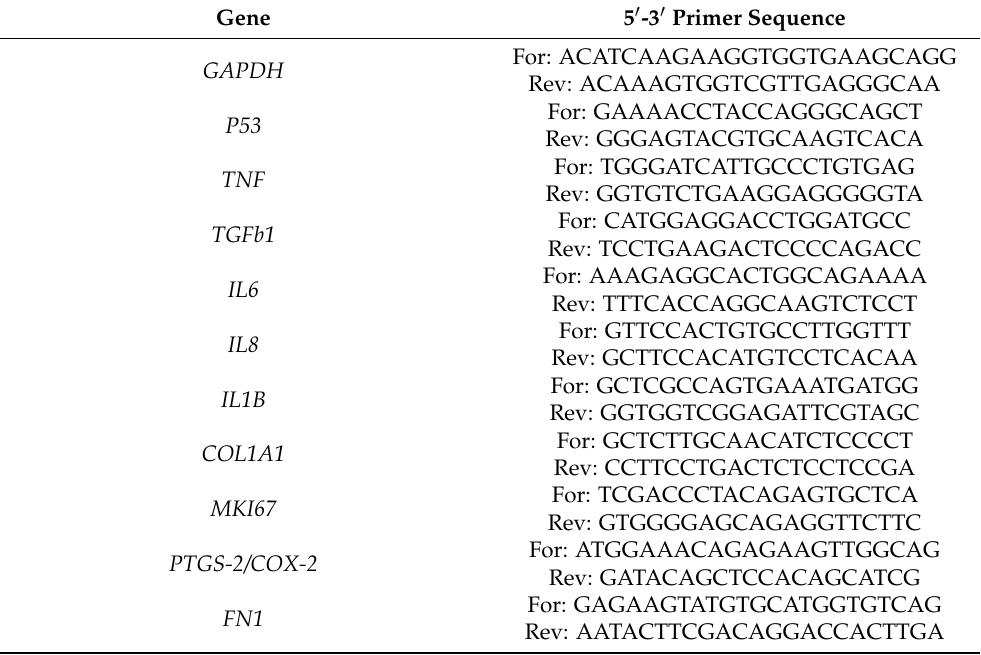
Table 2. qPCR primer